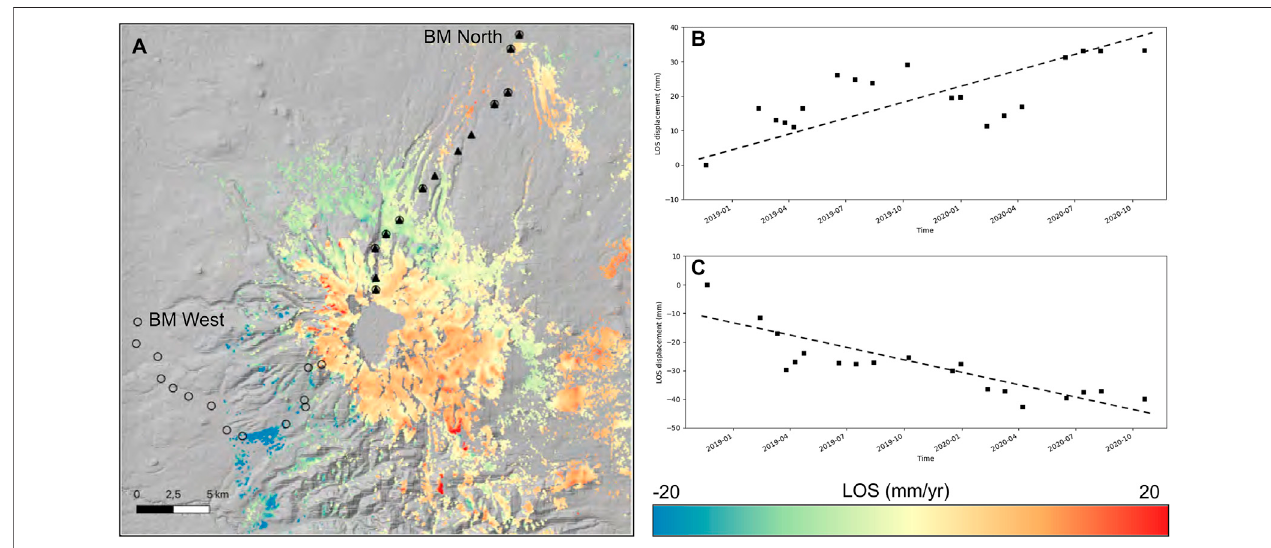
FIGURE2|(A) MeanvelocitymapfromInSAR(PS)processingofALOS-2data.Theopencirclesarethebenchmarksfromthewesternandnorthernlevelingroutes measured during the 2009 – 2011 campaigns, the full triangles are the northern leveling benchmarks measured during the 2002 – 2005 campaigns. (B,C) Displacement time series in the areas of maximum deformation, positive LOS velocity pixel (B) , negative LOS velocities pixel (C) .